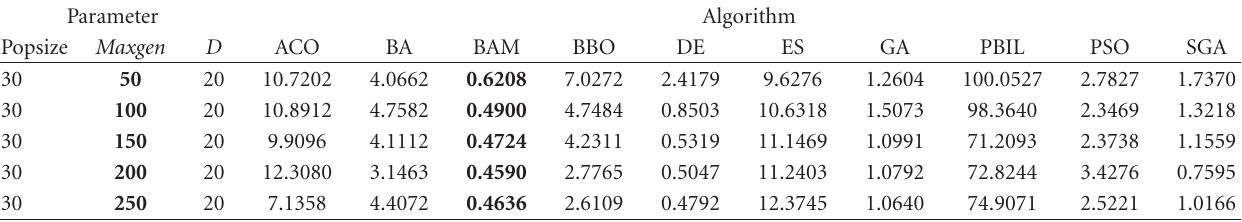
Table 2: Best normalized optimization results on UCAV path planning problem on di ff erent Maxgen . The numbers shown are the best results found after 100 Monte Carlo simulations of each algorithm.